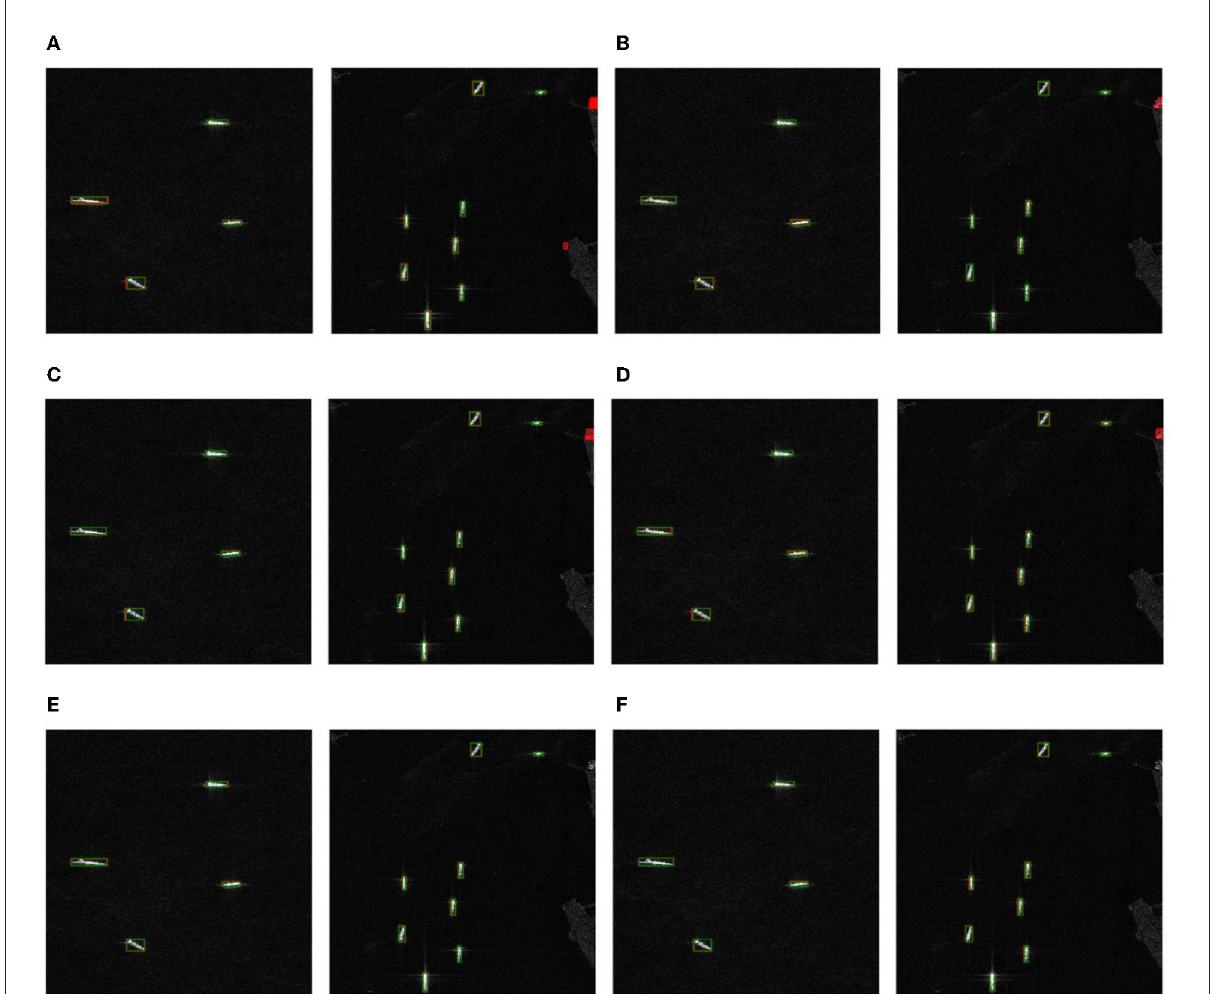
FIGURE5 Ship detection results of the target detection methods based on different models in simple far-sea and near-sea scenarios. The SAR images on the left are the far-sea scene, and the SAR images on the right are the near-sea scene. (A) Fast R-CNN. (B) Mask-RCNN. (C) Cascade Mask R-CNN. (D) RetinaNet. (E) FCOS. (F) Proposed